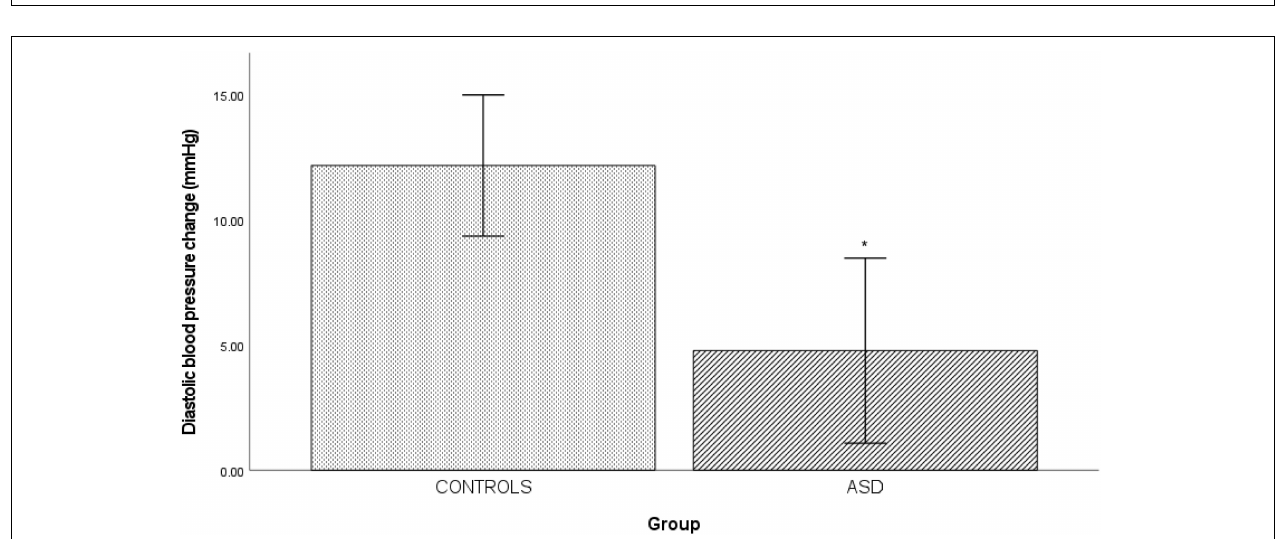
FIGURE 3 | Changes in mean diastolic blood pressure from baseline during isometric exercise in controls and ASD. mmHg, millimeters of mercury. *Refer to a statistically significant finding.